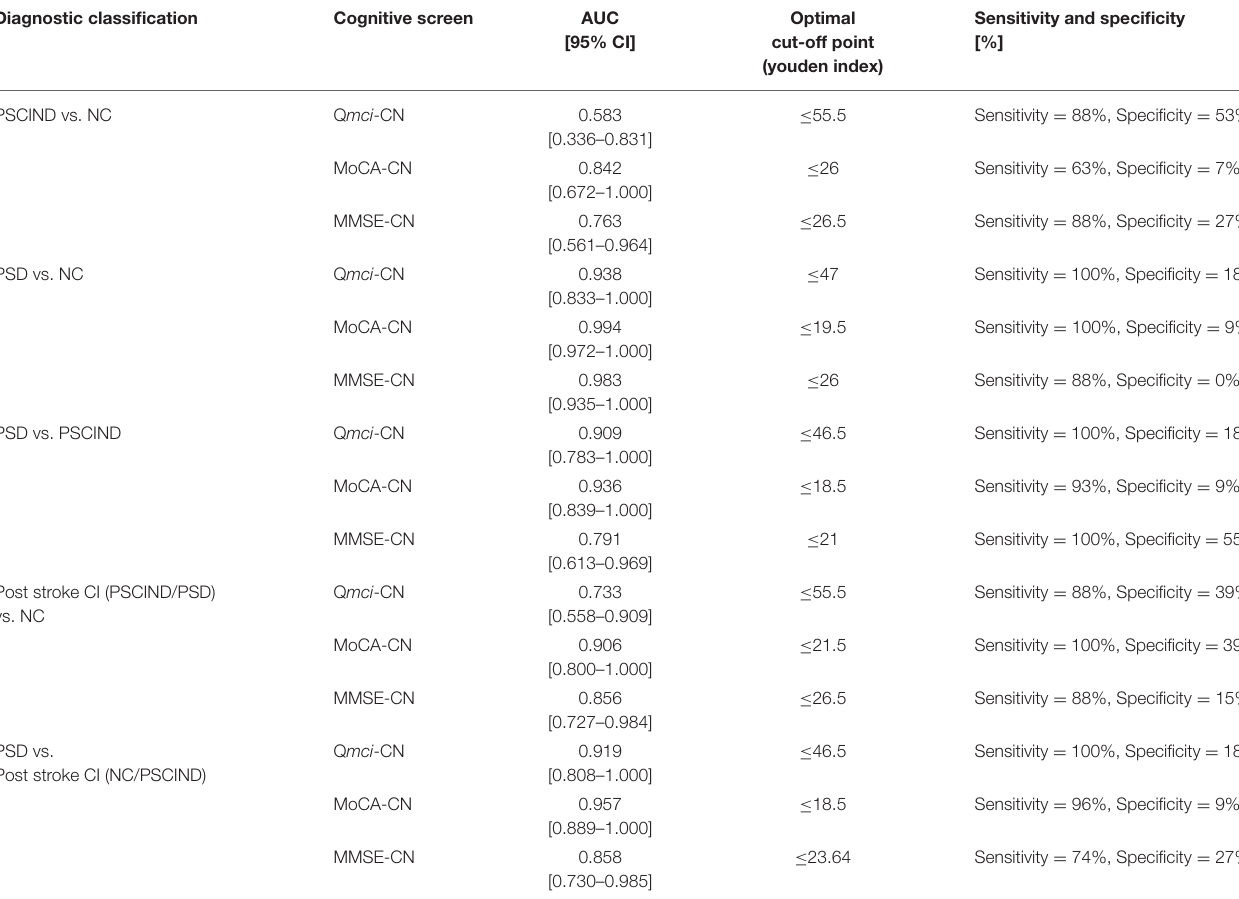
TABLE 4 | Area Under the Curve (AUC) values and optimal cut-offs for the Chinese versions of the quick mild cognitive impairment (Q mci -CN) screen, montreal cognitive assessment (MoCA-CN), and mini mental state examination